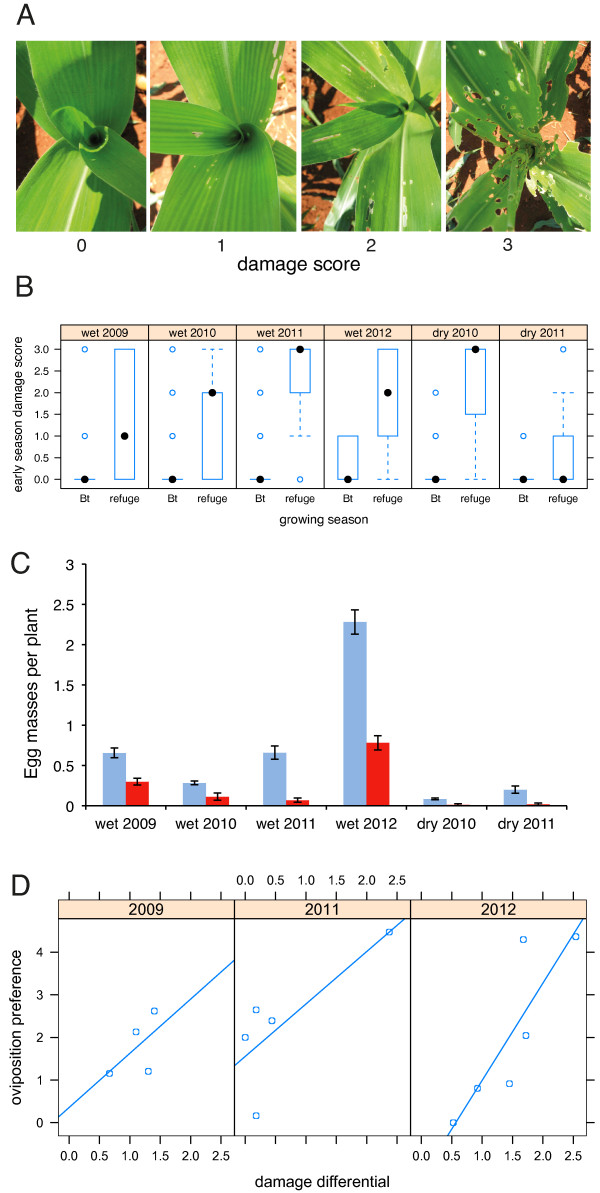
Feeding damage and oviposition preference of S. frugiperda in transgenic Bt plants and conventional refuge plants. (A) The damage scores of representative maize plants. (B) The variation in damage scores between transgenic Bt plants and conventional refugia plants. Box and whisker plots display medians (solid circles), lower and upper quartiles (boxes), the range (whiskers) and outliers (open circles). (C) Fall armyworm lay fewer egg masses on Bt plants (red bars) than on conventional plants (blue), than would be predicted by chance (Pearson’s χ2 = 92.9, df = 5, P < <0.0001), errors bars are ± SE. (D) The strength of preference for laying eggs in Bt maize increases with crop damage in the refuge within the growing season (overall slope = 1.4, SE = 0.38, t = 3.67, P = 0.0037). Data are from the wet growing seasons in 2009, 2011 and 2012. After taking the square roots of egg mass counts, preference is defined as egg masses per plant in Bt crop - egg masses per plant in refuge, while the damage differential is the difference in mean damage scores.